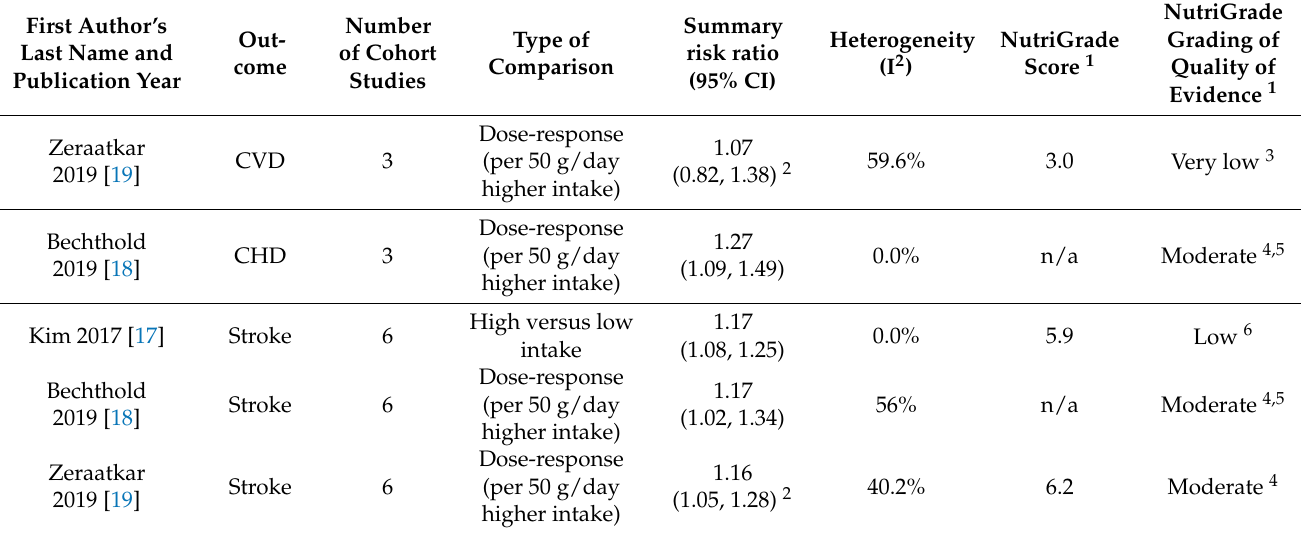
Table 6. Meta-analyses of associations between intake of processed meat and risk of CVD, CHD, and stroke, and NutriGrade meta-evidence